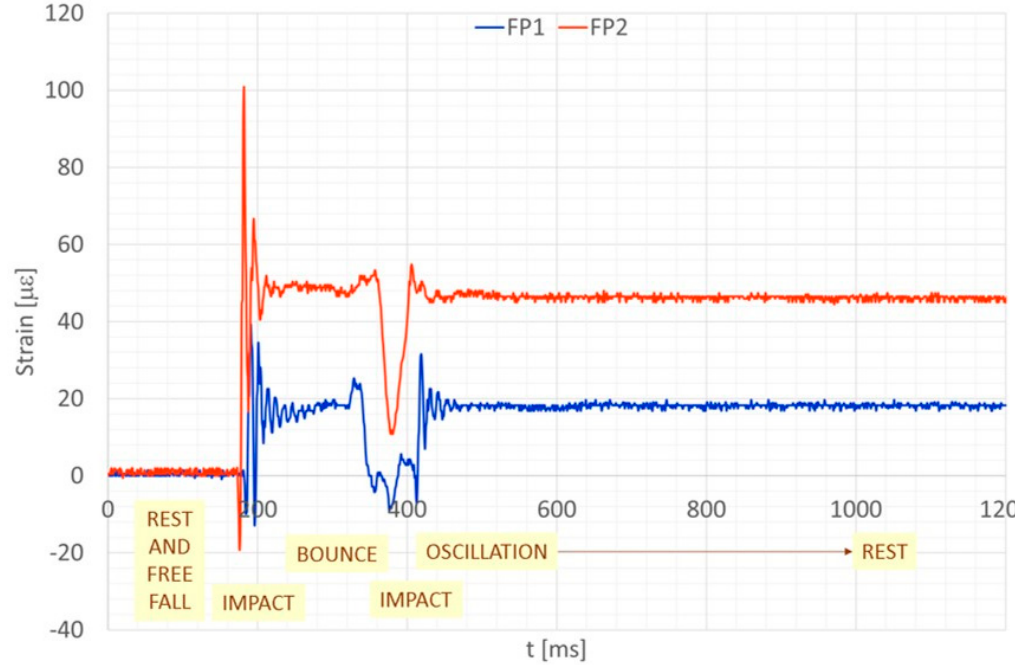
Figure 15. Typical impact plate-mounted FBG (FP1 and FP2) signals, as recorded during the drop tests. In this case, the starting height is set to 0.05 m.